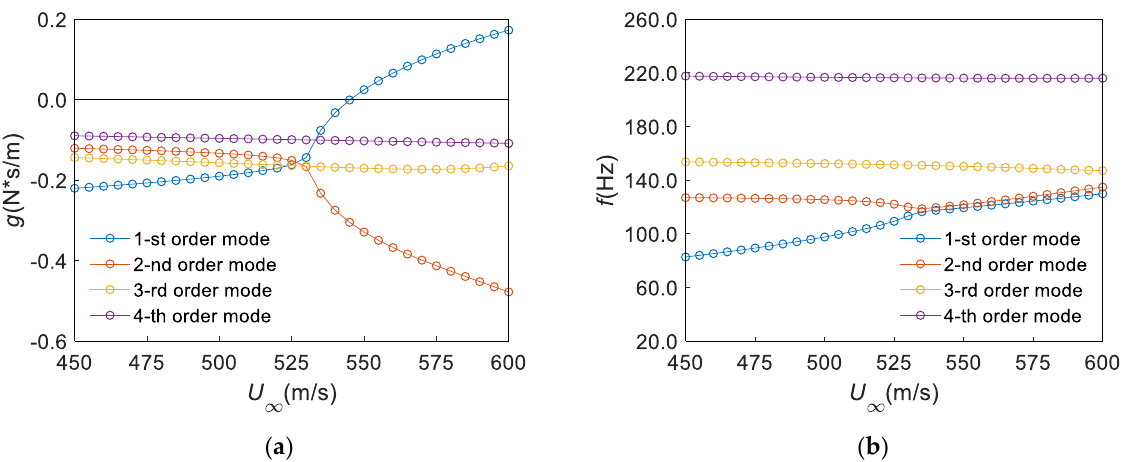
Figure 18. Results of flutter calculation for the panel with the 9P method damper configuration ( Ma ∞ = 2.0): ( a ) U − g , ( b ) U − f